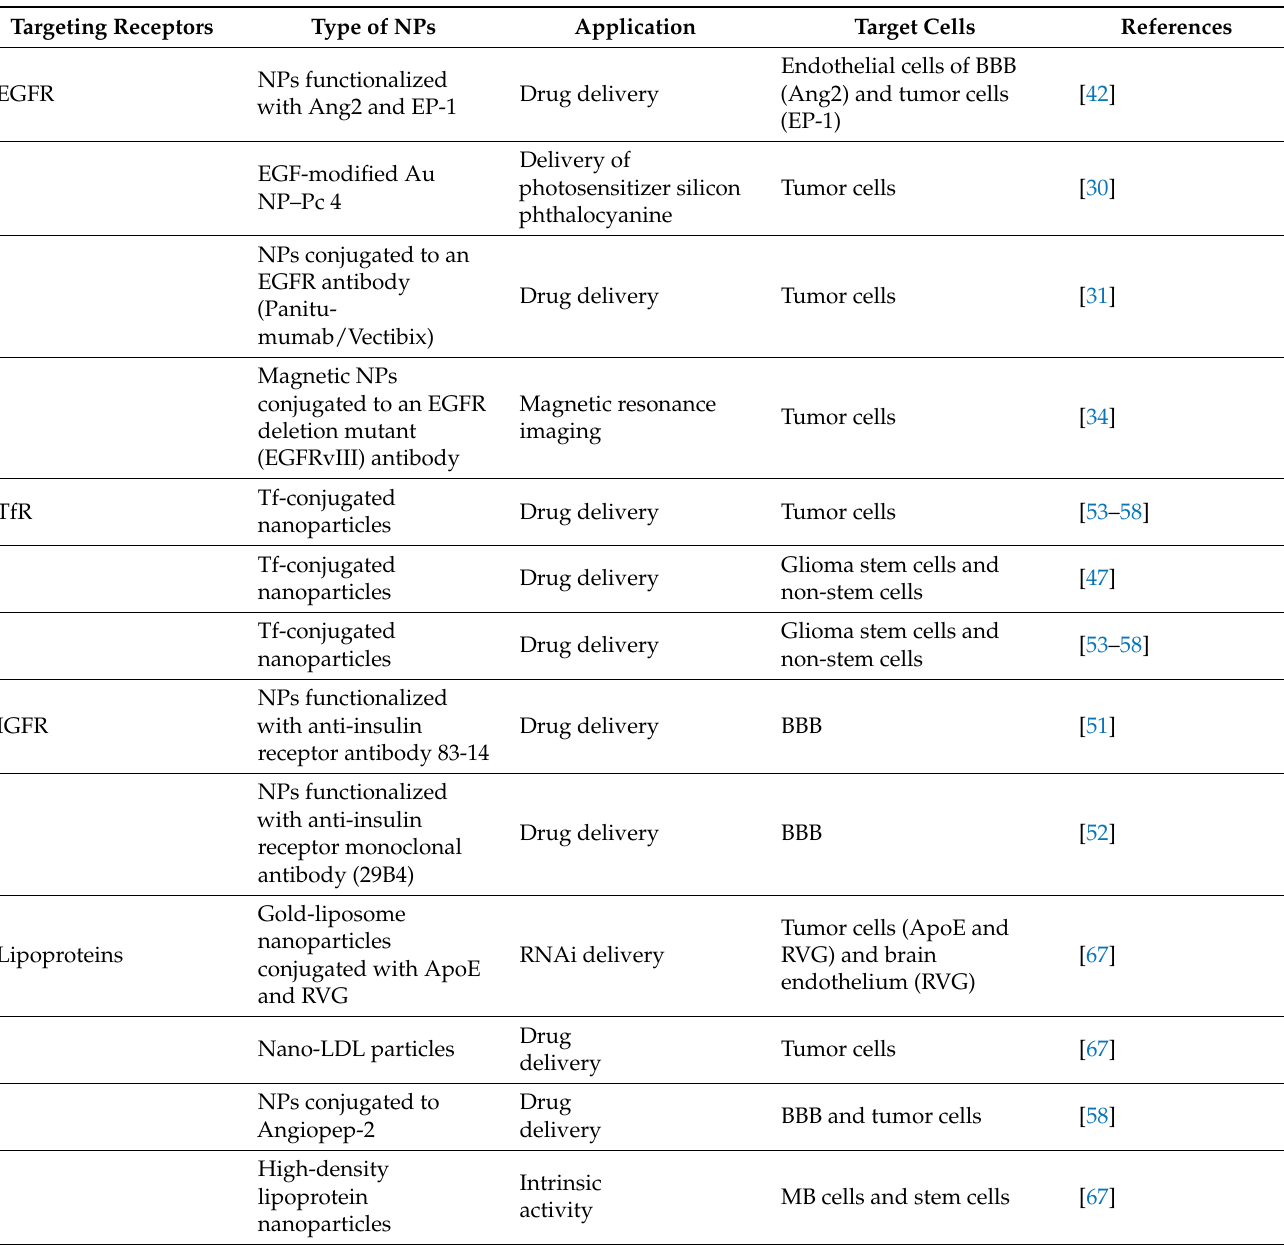
Table 1. Example of receptors on tumor cells and BBB cells used in brain tumor nano approaches. List of promising receptors for brain tumors nano